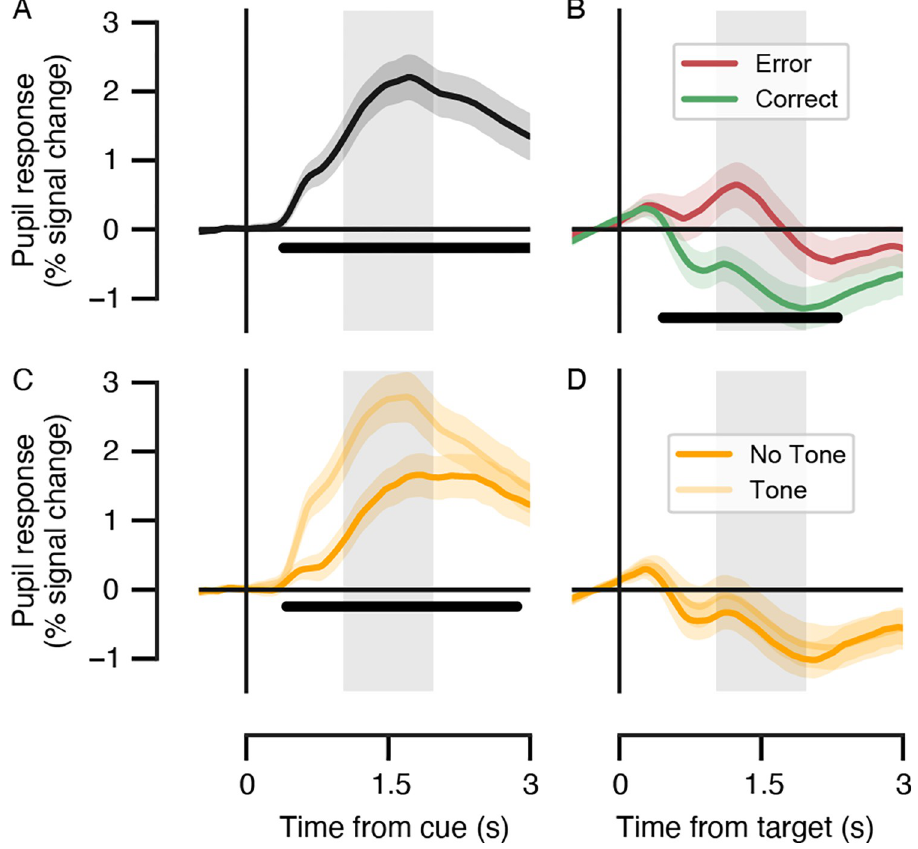
Fig 3. Pupil response time courses locked to the cue and target in the prediction task across both phases. All trials within the first and second phase of the prediction task were included in the evoked pupil response analysis. ( A ) Mean cue-locked pupil responses in the prediction interval. Black bar indicates main effect of cue, p < 0.05 (cluster-based permutation test). ( B ) Evoked pupil responses for correct and error trials in the feedback interval (target-locked). Black bar indicates correct vs. error effect, p < 0.05 (cluster-based permutation test). ( C ) Evoked pupil responses for tone and no tone trials in the prediction interval (cue-locked) and ( D ) in the feedback interval (target-locked). Black bar indicates tone vs. no tone effect, p < 0.05 (cluster-based permutation test). In all panels: variability around the mean responses is illustrated as the 68% confidence interval (bootstrapped; N = 30); the grey box indicates the temporal window of interest (1–2 s) with respect to event onset for the target-locked pupil responses. Note that the temporal window of interest was independently defined based on the pupil’s canonical impulse response